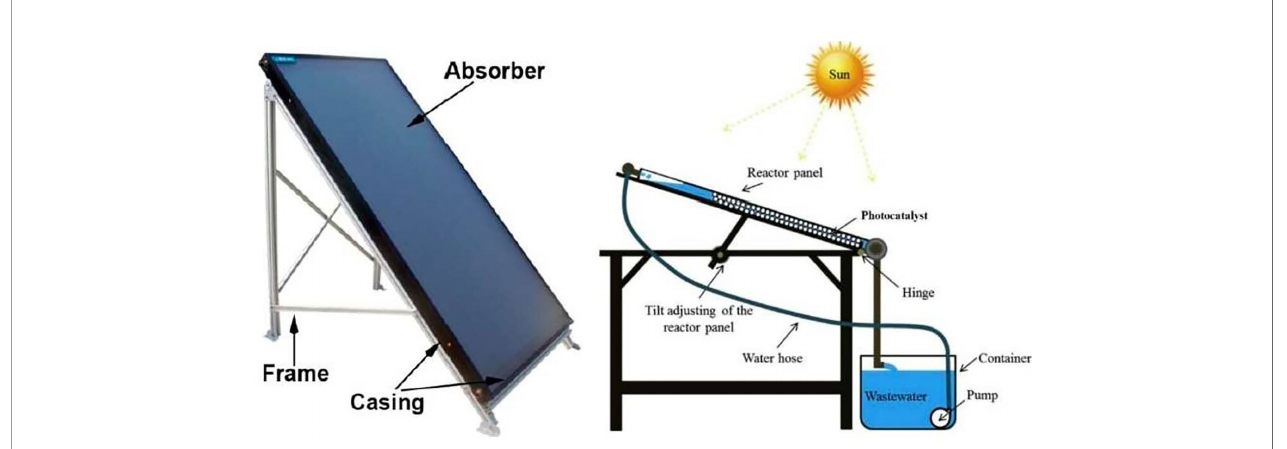
FIGURE 9 | Examples of inclined plate collectors prototype using TiO 2 nanoparticles coated on transparent beads for the remediation of methylene blue under solar illumination. Reproduced with permission (Fendrich et al., 2018).